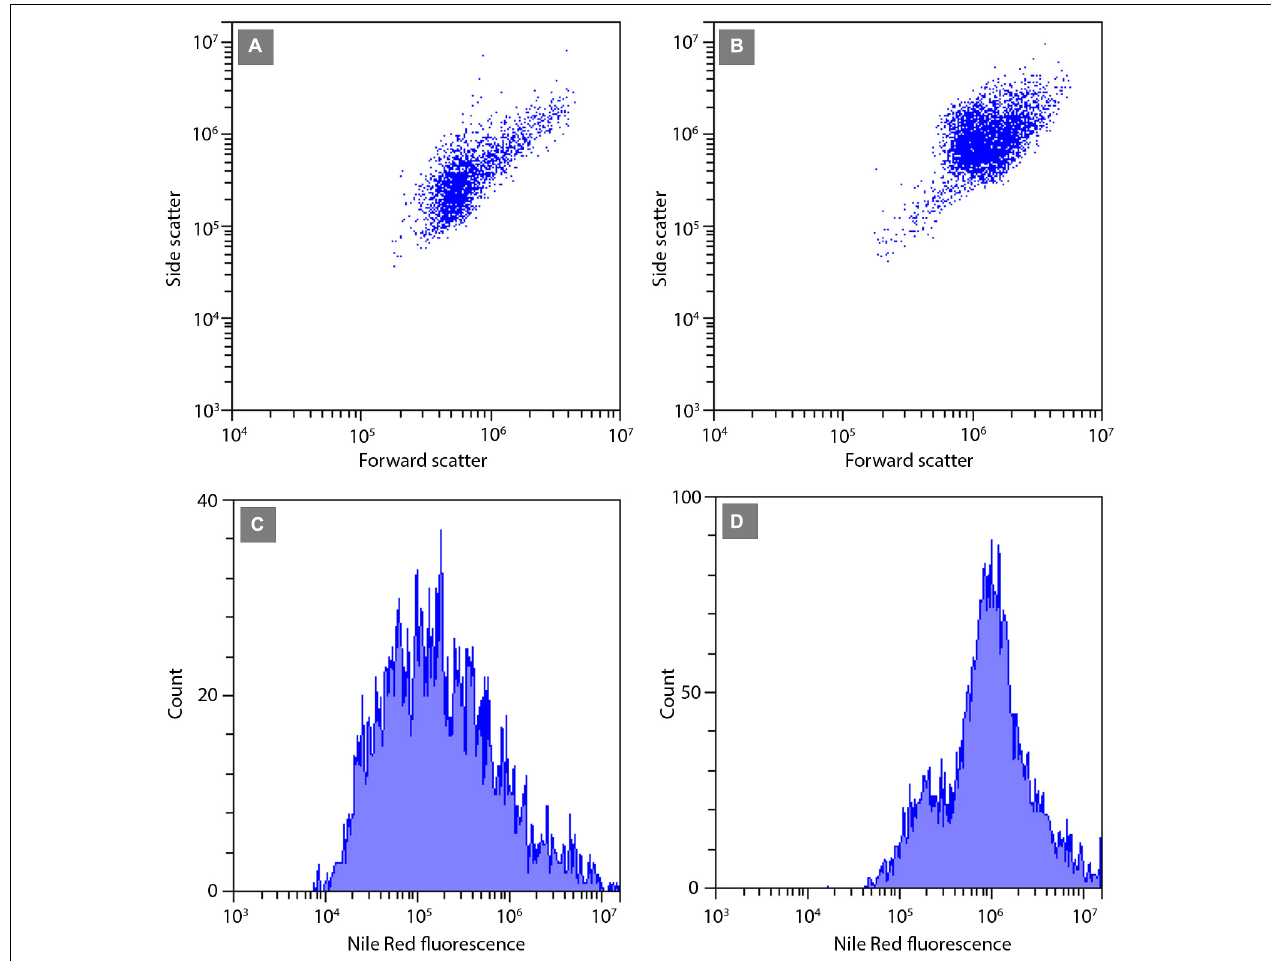
FIGURE 6 | Flow cytometric signatures of the smallest SZCZ E1427 (A,C) and largest SZCZ E1768 (B,D) strains of S. trachyderma . (A,B) Dot plots of algal cells forward scatter (relative units) vs. side scatter (relative units). (C,D) Frequency histograms of algal cells Nile Red fluorescence (relative